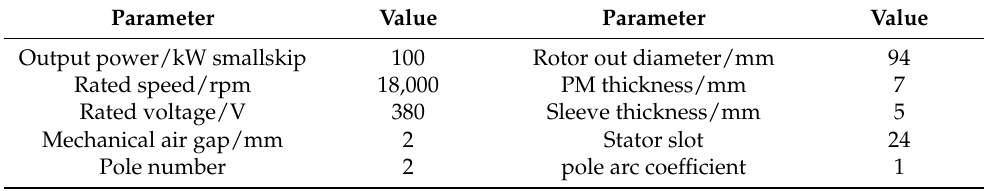
Figure 20. Prototype experimental platform. Table 4. Main parameters of